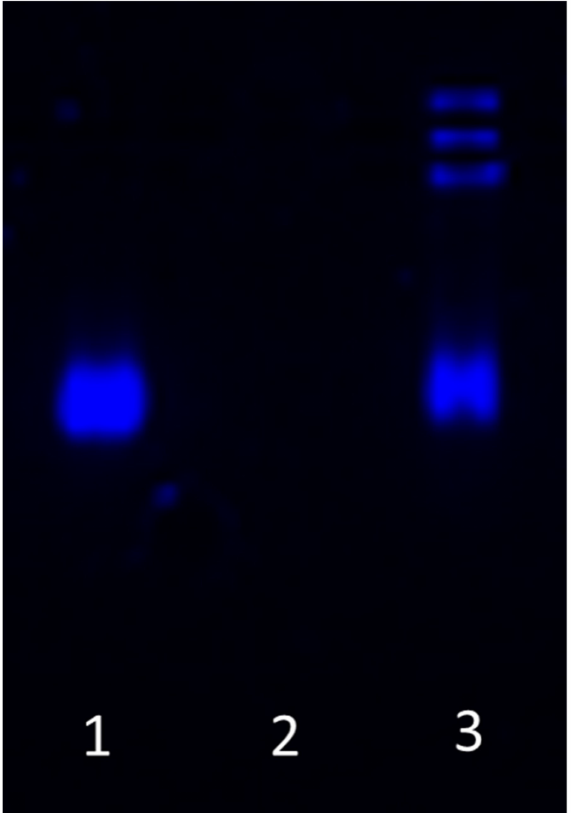
Figure 1. Migration of mRNA in agarose gel. ( 1 ) Free mRNA; ( 2 ) mRNA loaded nanoparticles;